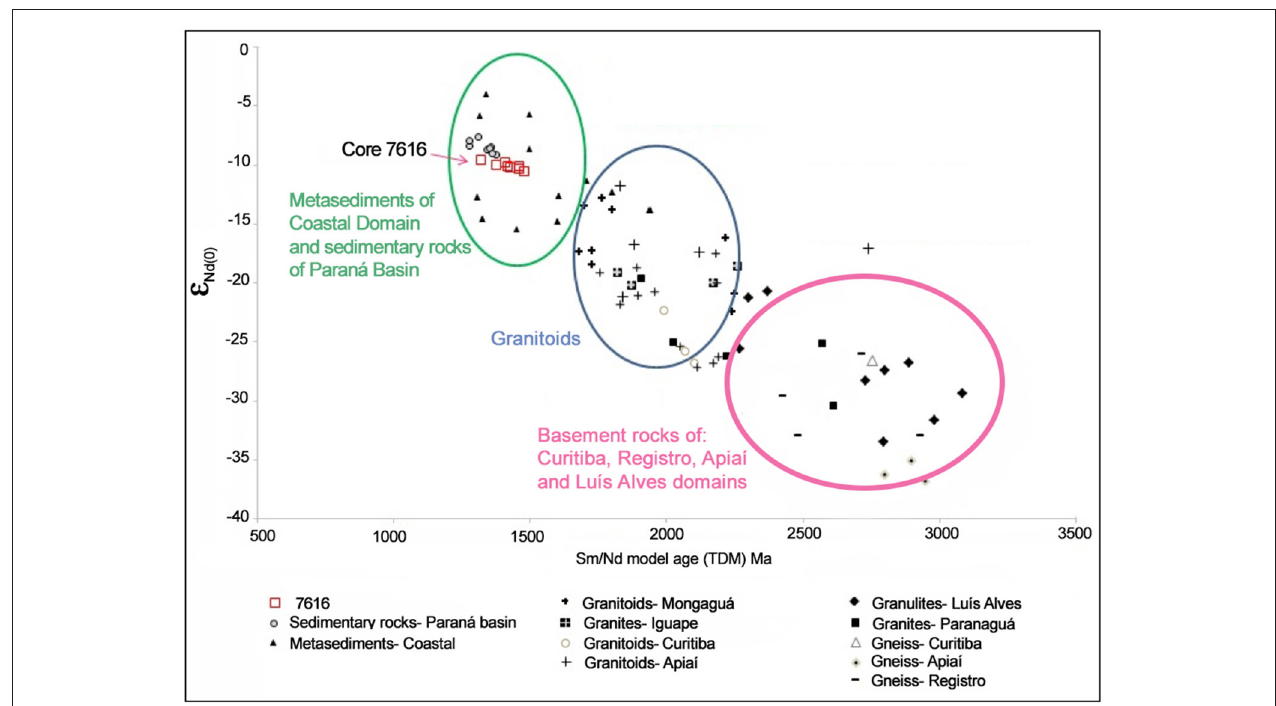
FIGURE 3 | Diagram showing ε Nd(0) values vs. Sm/Nd model ages (T DM ) of the Core 7616 and investigated source rocks (Ma).